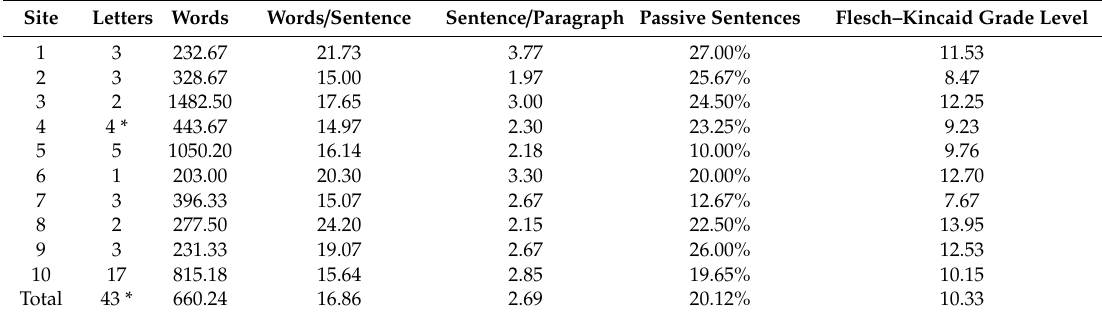
Table 3. Readability statistics by site.